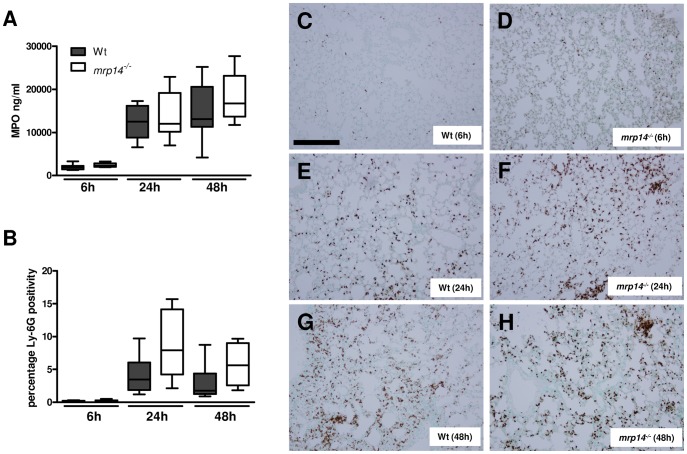
Neutrophil influx in Klebsiella pneumonia is not influenced by MRP14 deficiency.MPO levels in whole lung homogenates (A) and quantitation of pulmonary Ly-6G positivity 6, 24 and 48 hours after infection (B) in Wt (grey) and mrp14−/− mice (white). Data are expressed as box-and-whisker diagrams depicting the smallest observation, lower quartile, median, upper quartile and largest observation (8 mice per group at each time point). There were no statistically significant differences between the groups. Representative neutrophil stainings (brown) of Wt (C) and mrp14−/− mice (D) 6 hours, Wt (E) and mrp14−/− mice (F) 24 hours and Wt (G) and mrp14−/− mice (H) 48 hours after induction of K. pneumoniae pneumonia.. Scalebar indicates 200 µm.